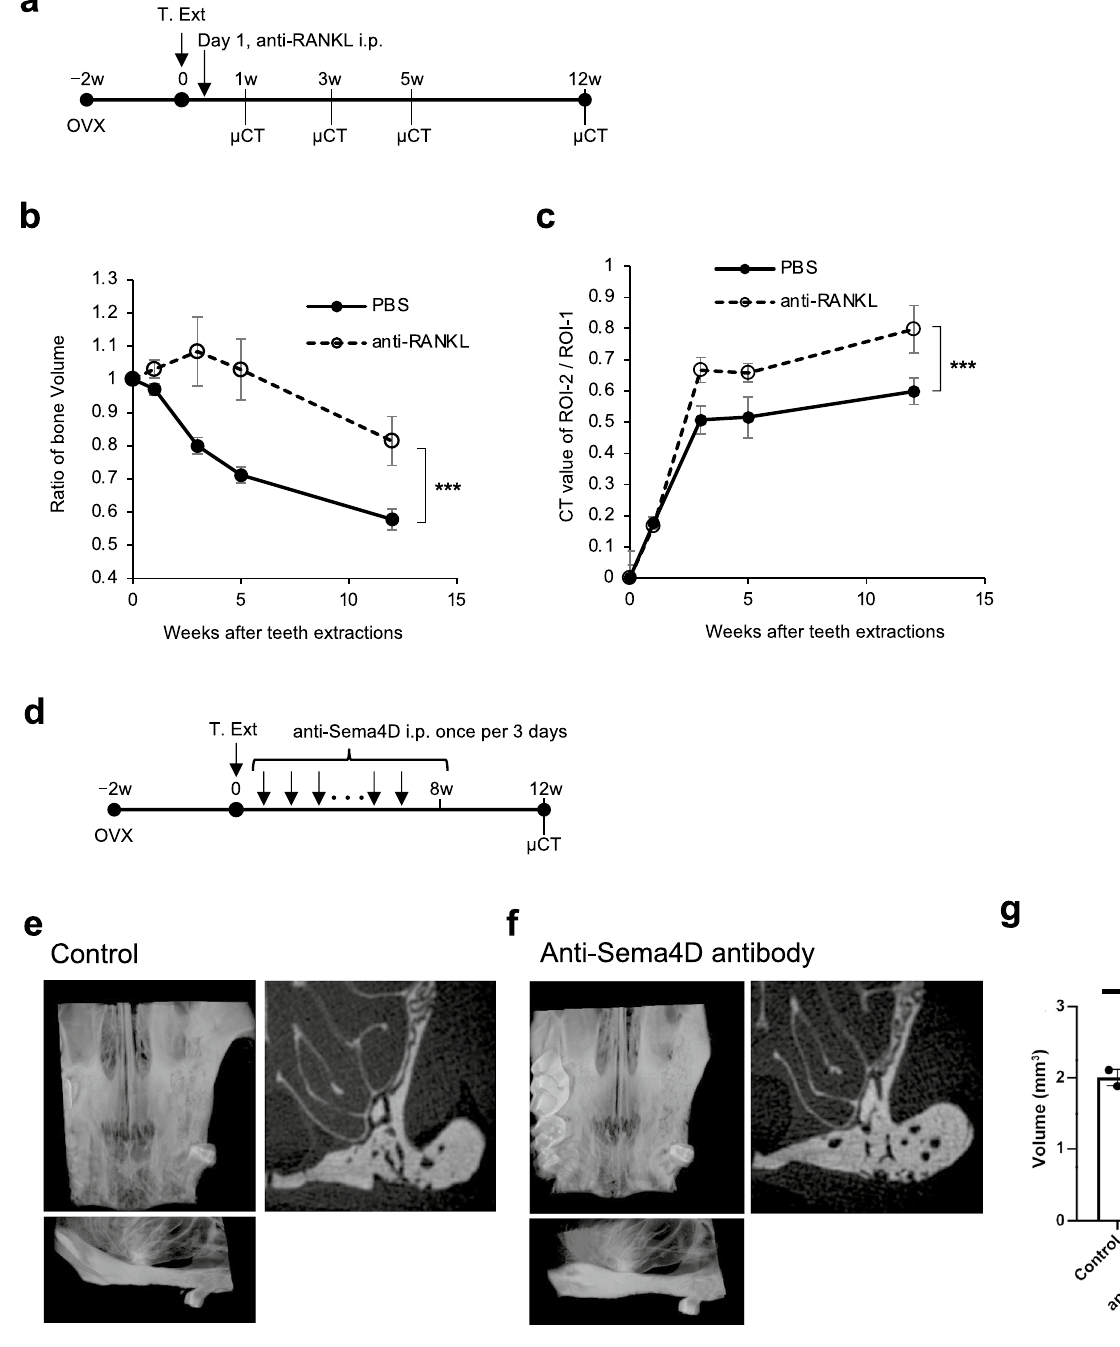
Figure 5. Administration of neutralization antibodies for RANKL or Sema4D can prevent prolonged bone resorption of the maxillary alveolar bone of OVX mice. ( a ) Experimental scheme of administration of the neutralization antibody and µCT observation. T.Ext; teeth extractions. ( b ) The graph shows the time-dependent changes in the bone volumes of the teeth-extracted side of the alveolar bone of OVX mice administrated with anti-RANKL antibody (open circle) or PBS as control (closed circle), as described in Fig. 1a. Data are expressed as mean ± S.D. (n = 3). ( c ) The graph shows the time-dependent changes in the ratio of CT values of the maxillary alveolar bone of OVX mice as described in Fig. 1b. Open circles represent the mice administrated with anti-RANKL antibody and closed circles represent PBS as control (closed circle). The data shown in the graphs are representative of two independent experiments. *** P < 0.005; calculated using two-way ANOVA. ( d ) Experimental scheme of administration of the neutralization antibody and µCT observation. T.Ext; teeth extraction. ( e and f ) Ventral views (upper left images) and lateral views (lower images) of μCT-3D images of the maxillary bone, and the µCT images of extraction socket of the first molar (right images) at 12 weeks post-extraction of OVX mice. The images are the alveolar bone of OVX mice administrated with PBS as the control ( e ) and anti-Sema4D antibody ( f ). ( g ) The graphs show maxillary alveolar bone volumes at 12 weeks after teeth extractions of OVX mice administrated with anti-Sema4D antibodies. Controls are the volume of alveolar bone of mice that have had ovariectomy and tooth extraction but have not been administered antibodies. The mice were euthanized at 12 weeks following teeth extractions. The heads were removed and subjected to µCT analysis, and the BV were measured. The data shown in the graphs are representative of two independent experiments. ** P < 0.01 (calculated using Student’s t